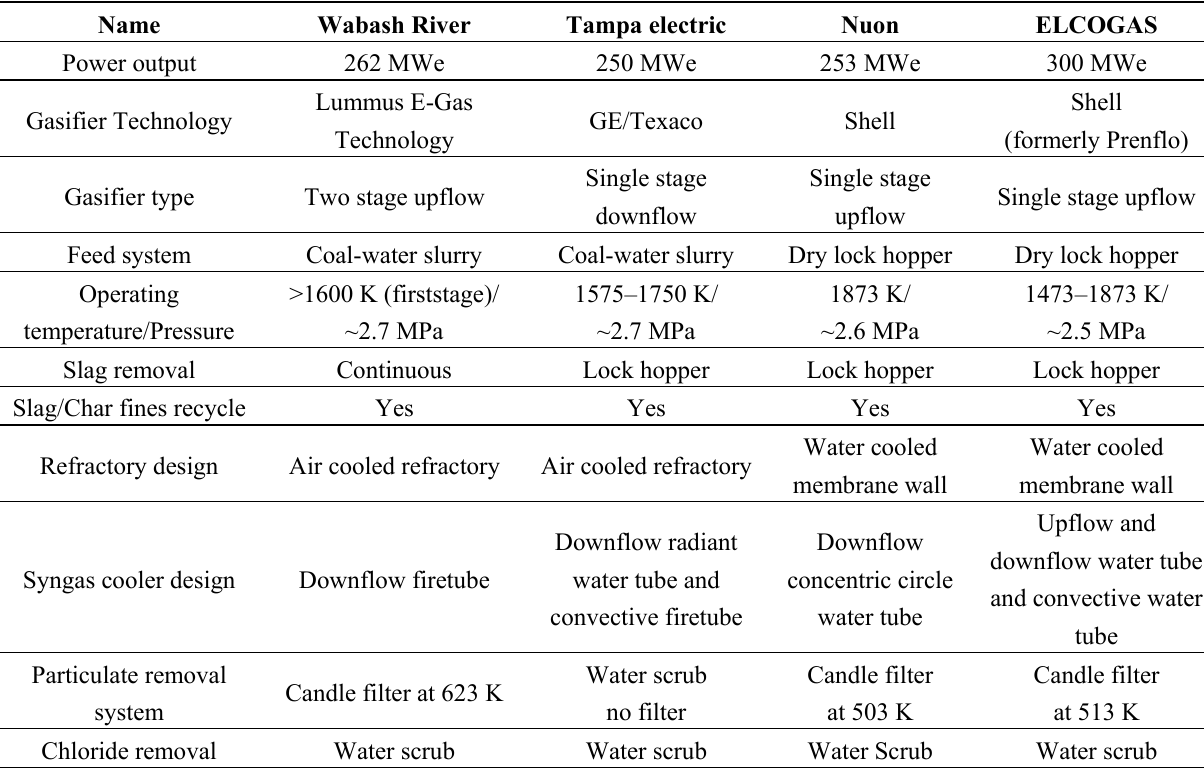
Table 3. Design of major coal based-IGCC plants with entrained flow gasifiers [24,72–74].